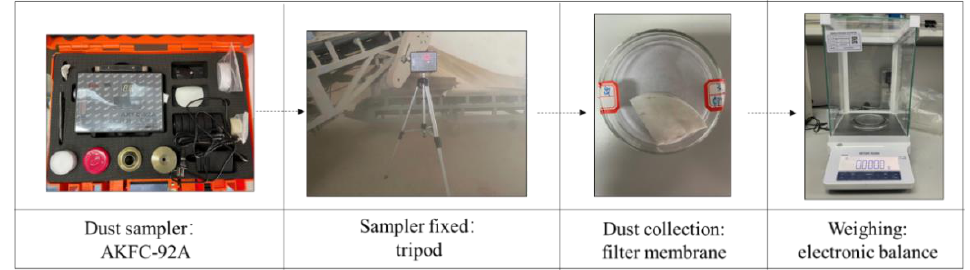
Figure 2. Dust concentration measuring instrument.